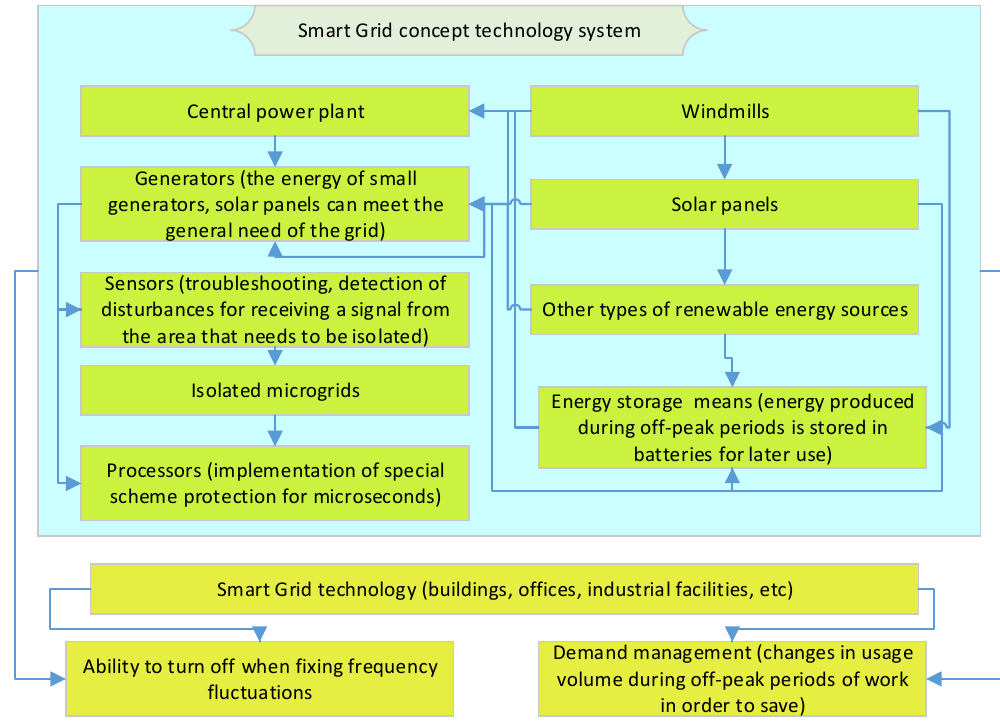
Fig. 4: “Smart electrical grid” structure